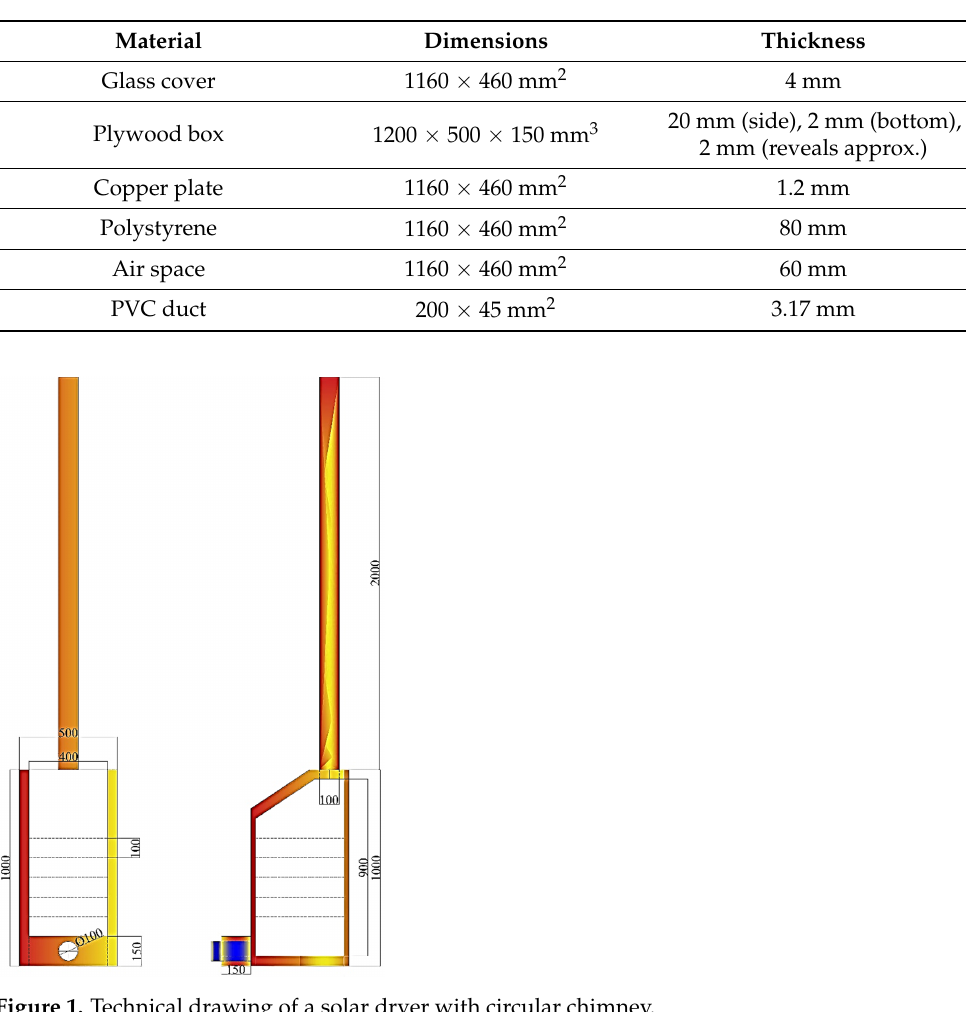
Figure 3. Schematic diagram of the solar drying unit Dhaundiyal et al., 2021 [31].